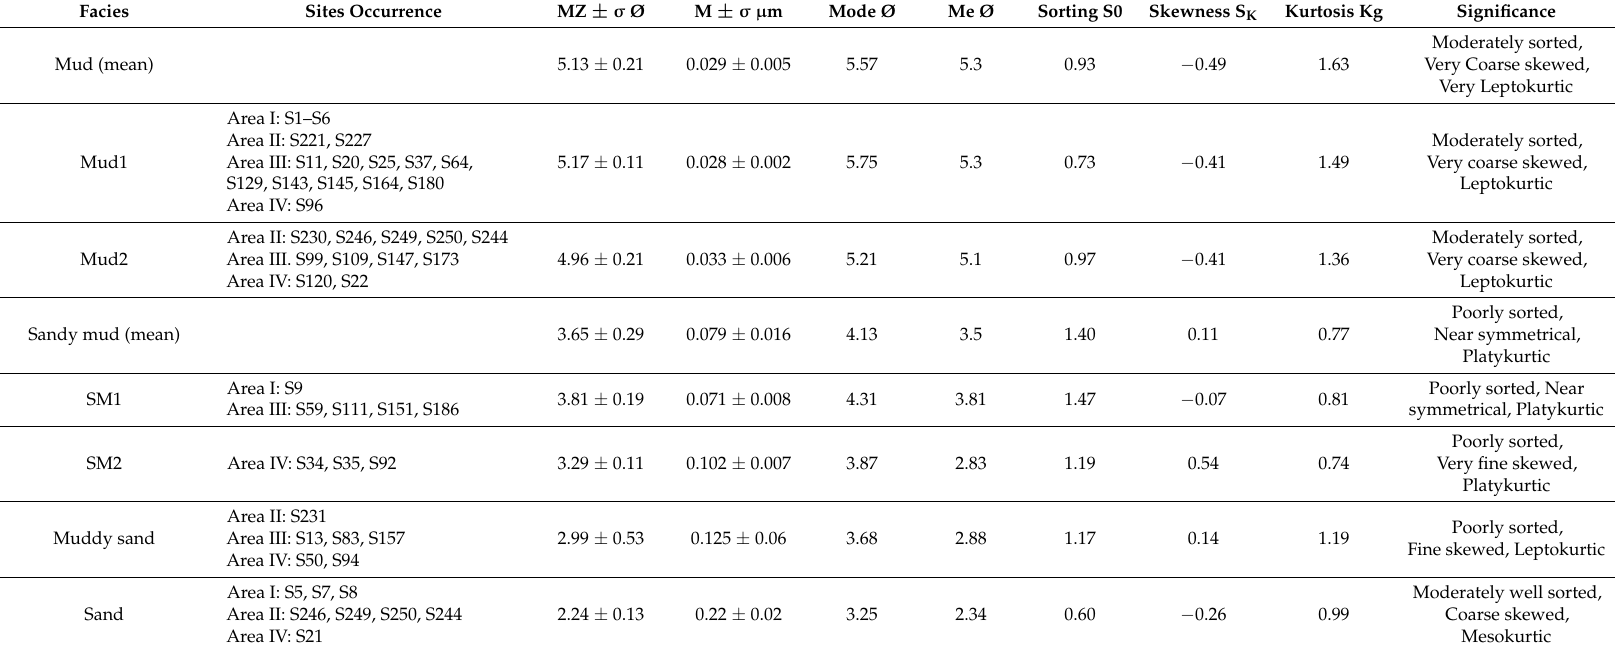
Table 4. Grain size attributes of mud, sandy mud, muddy sand and sub-facies M1, M2, SM1 and